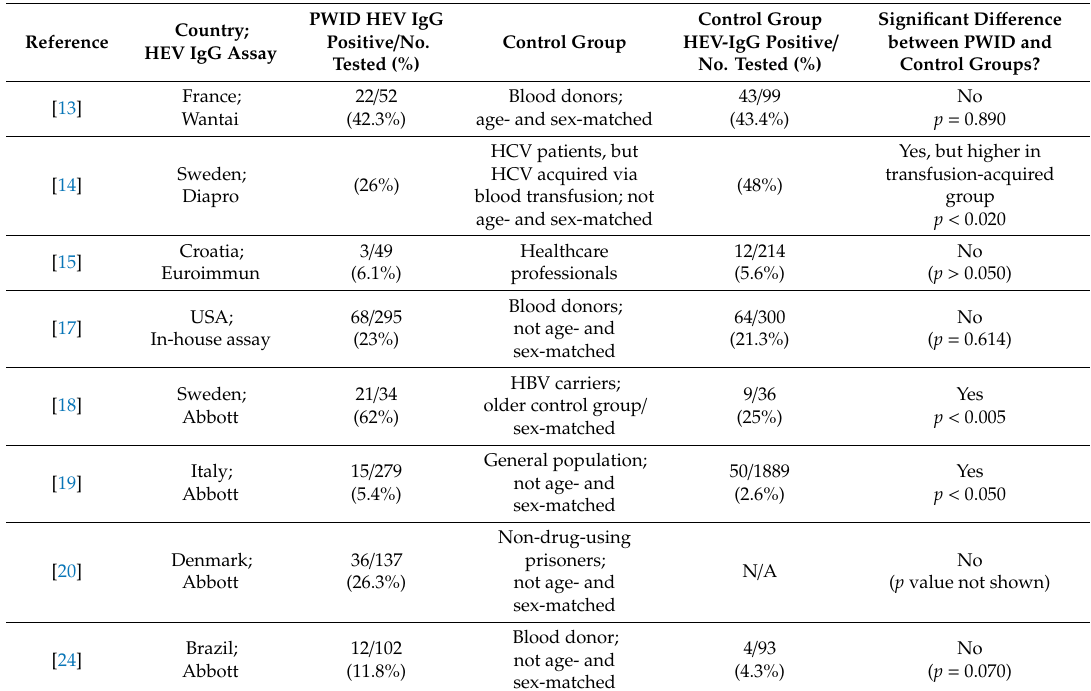
Table 2. Previous studies on HEV seroprevalence among PWIDs including control